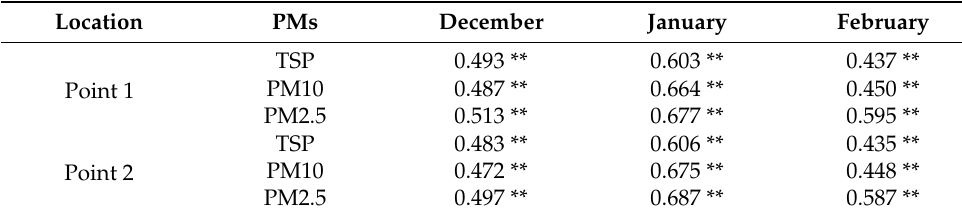
Figure 4. Monthly average relative humidity at both points. Table 7. Correlation coefficient between PMs and different levels of relative humidity.